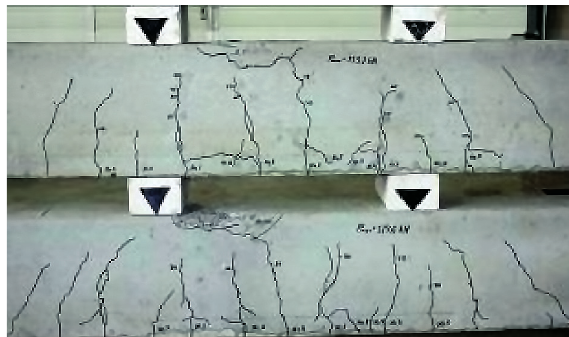
Fig. 6. Failure mode and distribution of cracks of beams S-1 and S-2